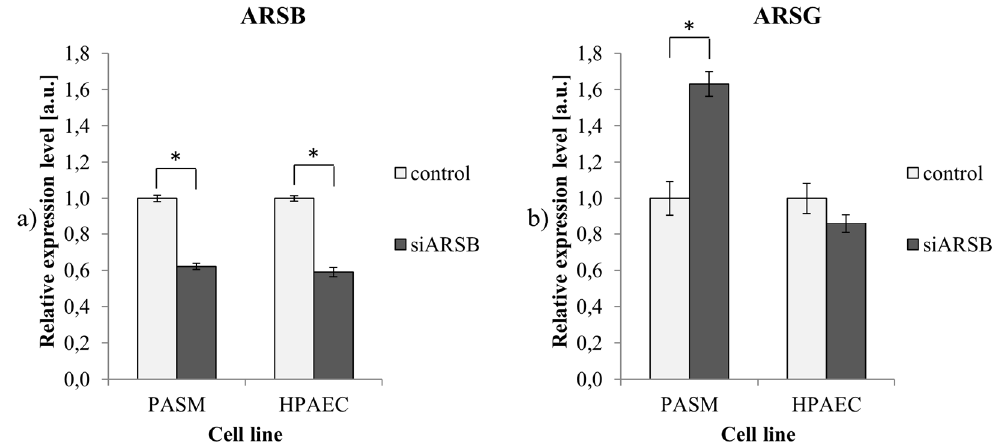
Figure 2. Expression of ARSB and ARSG. ( a ) The e ffi ciency of ARSB gene silencing in PASM and HPAEC cells using siRNA; ( b ) expression of ARSG transcript in PASM and HPAEC cells with a depleted ARSB gene. Results are shown as mean ± SD from three biological experiments. *—statistically significant changes (compared to controls treated with non-targeting siRNA; p -value < 0.05).